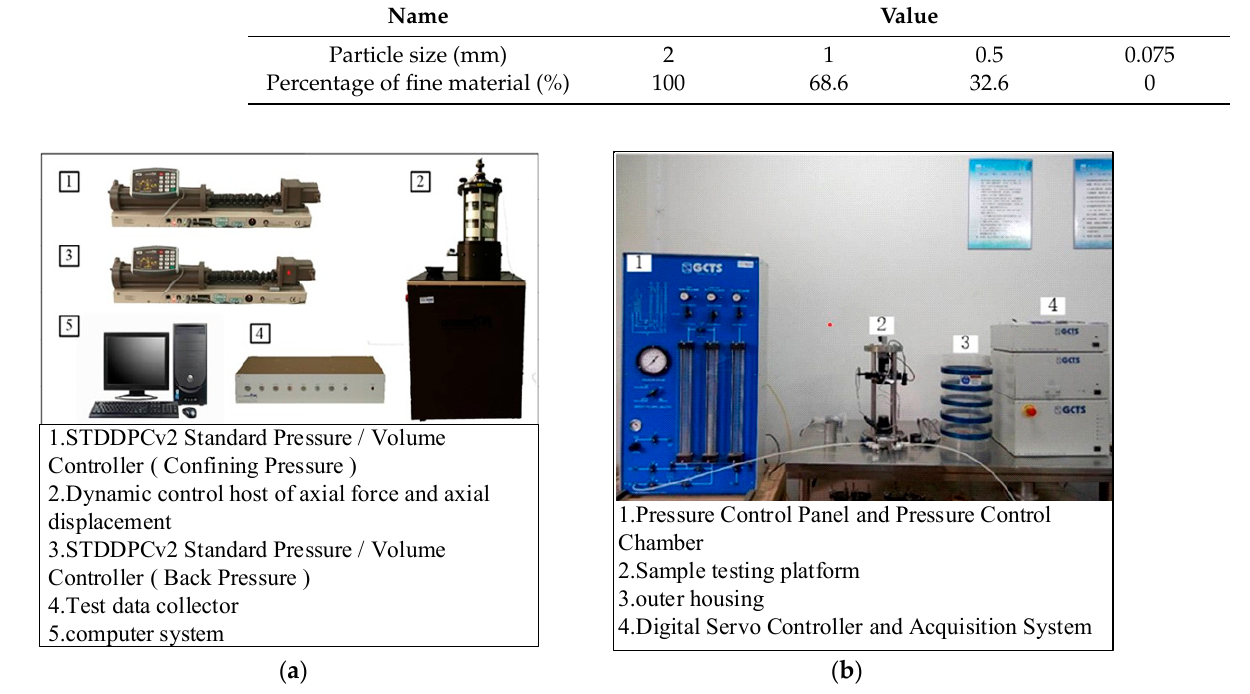
Figure 3. Test instruments used in the current study. ( a ) GDS dynamic triaxial test apparatus, ( b ) TSH-100 type resonant column testing